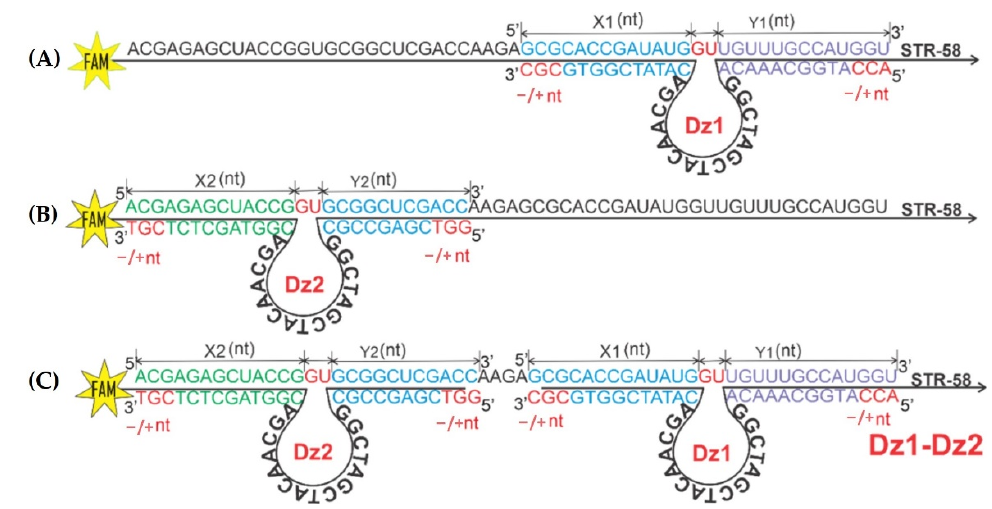
Figure 5. Chemically modified monovalent 10-23 Dz. 10-23 Dz was modified by removal or addition of nucleotides (nt). Red sequence represents binding arm modifications and cleavage sites (GU). X1 (blue) and X2 (green) are the binding arms at the 3′ end of Dz1 and Dz2. Y1 (purple) and Y2 (blue) are the binding arms at the 5′ end of Dz1 and Dz2. ( A ) Monovalent Dz1 cleaving at first cleavage site. ( B ) Monovalent Dz2 cleaving at second cleavage site. ( C ) Monovalent Dz association cleaving at Dz1 and Dz2 cleavage sites. nt = nucleotide. Table 3. Nucleotide lengths and melting temperatures of Dz1 and Dz2 binding arms .